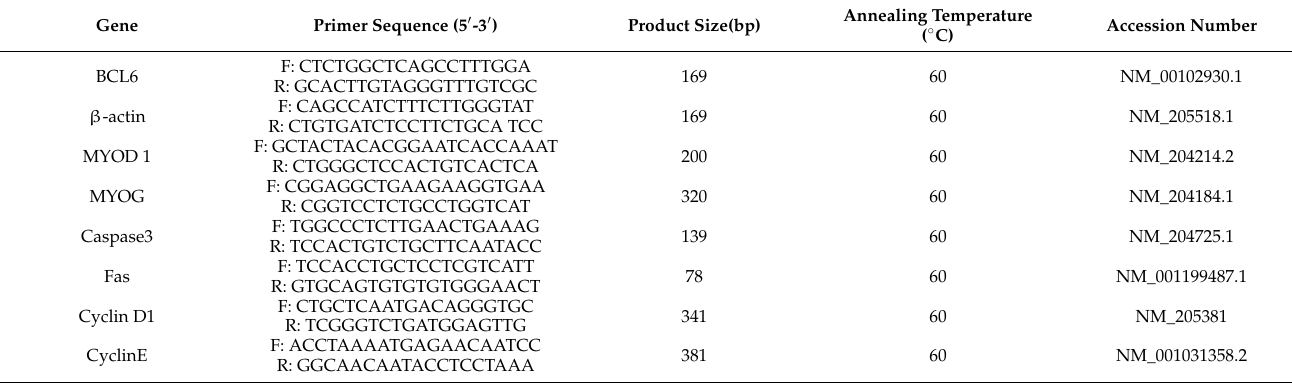
Table 2. Gene primers used for